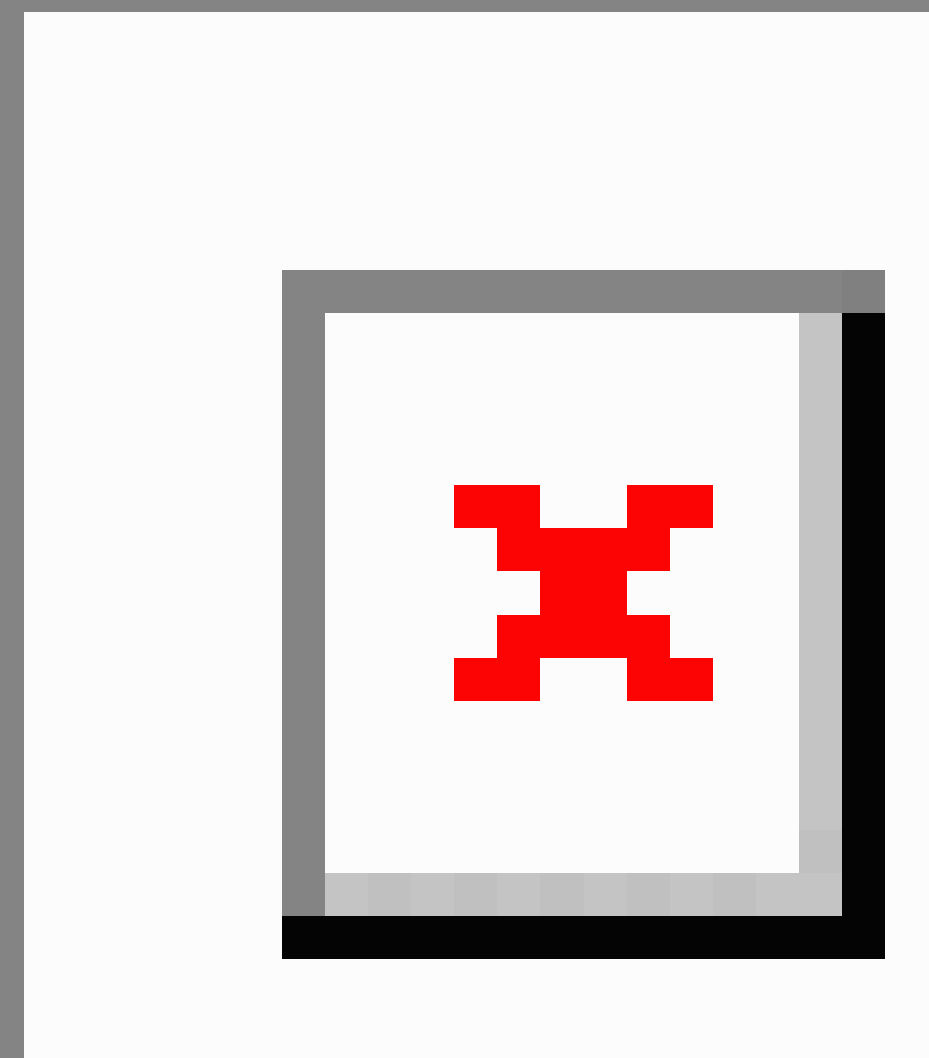
Figure 1. Flowchart of